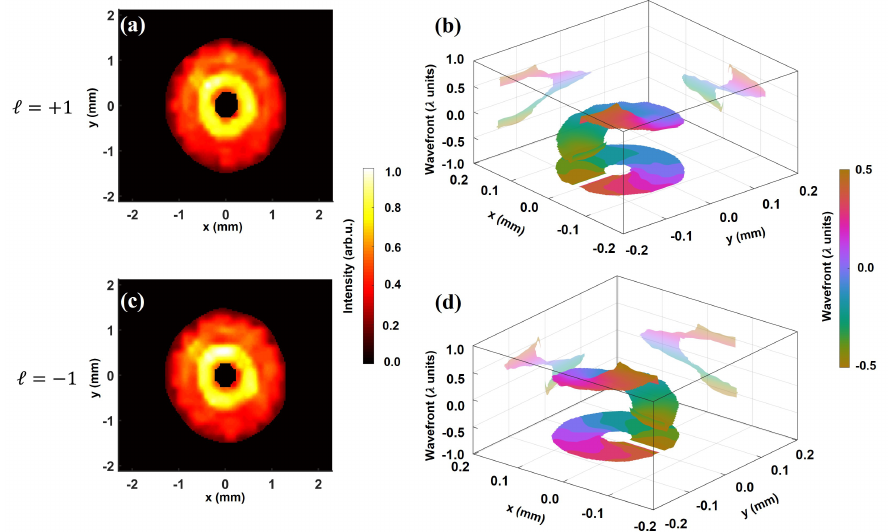
Figure 2. Characterization of low topological charge vortex beam. Reconstructed intensity ( left ) and wavefront ( right ) from single-shot raw Hartmanngram for beam of (cid:96) = + 1 ( a ) and (cid:96) = − 1 ( c ). The intensity distribution exhibits a dark central spot in both cases. The vertical axis in ( b , d ) represents the wavefront in the unit of wavelength λ . The wavefronts manifest a helical structure with an overall peak-to-valley value of ∼ 1 λ , designating the unit topological charge. The handedness of wavefront rotation changes from clockwise ( b ) to counterclockwise ( d ) when the sign of the topological charge changes from positive to negative.